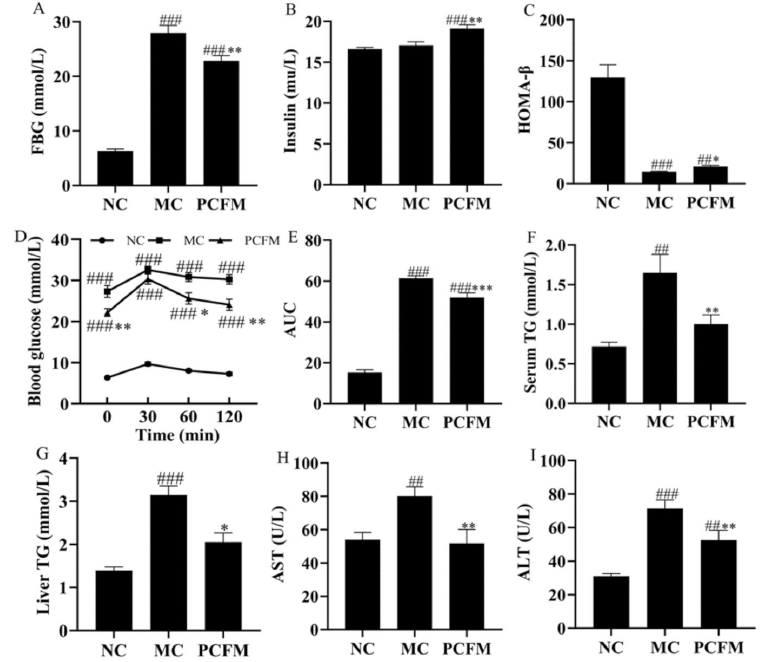
Figure 2. After 5 weeks’ treatment, e ff ect of prolamin from cooked foxtail millet (PCFM) administration on levels of ( A ) Fasting blood glucose (FBG), ( B ) Insulin, ( C ) Homeostasis model assessment—islet β cell function (HOMA- β ), ( D ) Oral glucose tolerance test (OGTT), ( E ) Area under curve (AUC), ( F ) Serum triglyceride (TG), ( G ) liver TG, ( H ) Aspartate aminotransferase (AST) and ( I ) Alanine aminotransferase (ALT) in mice. Values were analyzed by One-way analysis of variance (ANOVA) followed by Duncan’s post-hoc test and expressed as the mean ± SEM of 8 mice / group. ### p < 0.001, ## p < 0.01, compared to normal control (NC) group, *** p < 0.001, ** p < 0.01, * p < 0.05, compared to model control (MC)